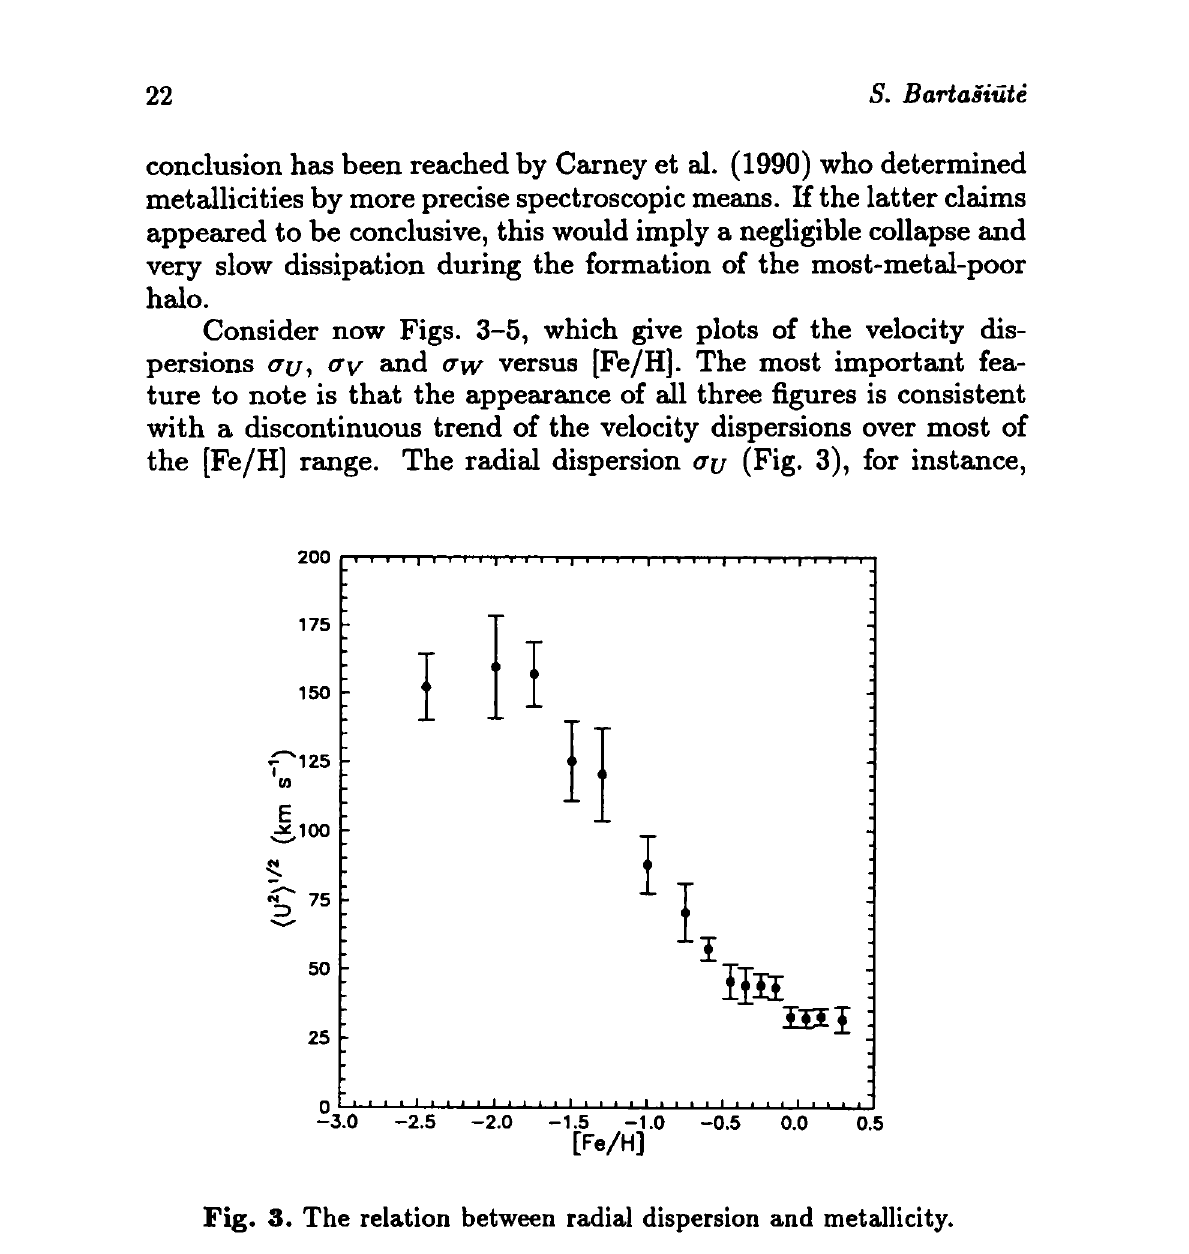
Fig. 3. The relation between radial dispersion and